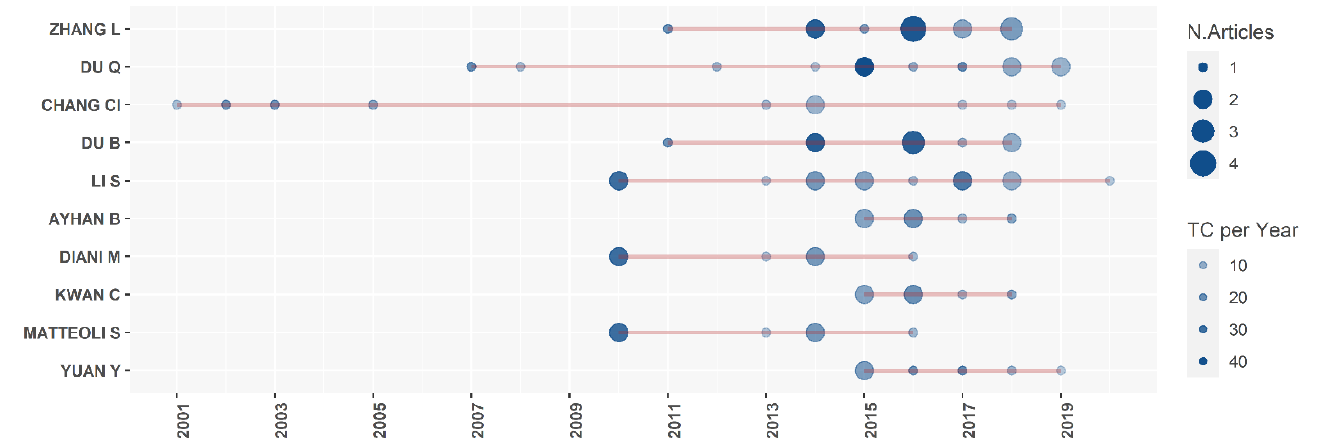
Figure 3. Scientific production of top 10 authors in the field over the time span of the research, determined and sorted by number of articles (N. articles) and total number of citations per year (TC per year). The figure was created using the bibliometrix R-package